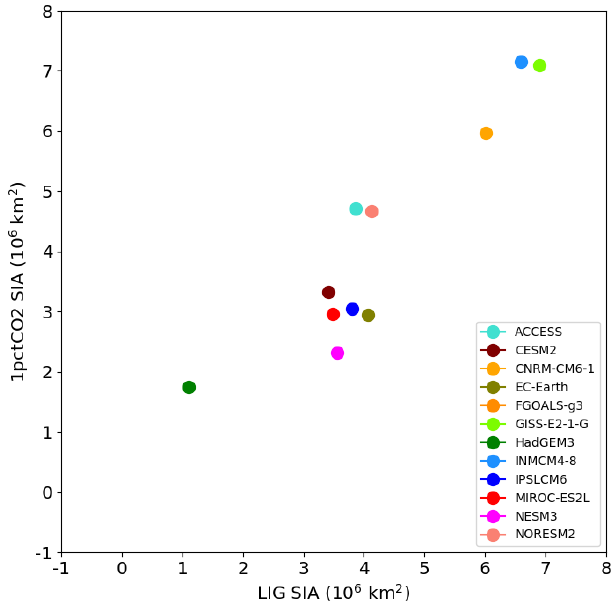
Figure 12. LIG vs. 1pctCO2 July–August–September sea ice ar- eas (for sea ice concentrations larger than 0.15). The results for the 1pctCO2 simulations have been averaged for years 50 to